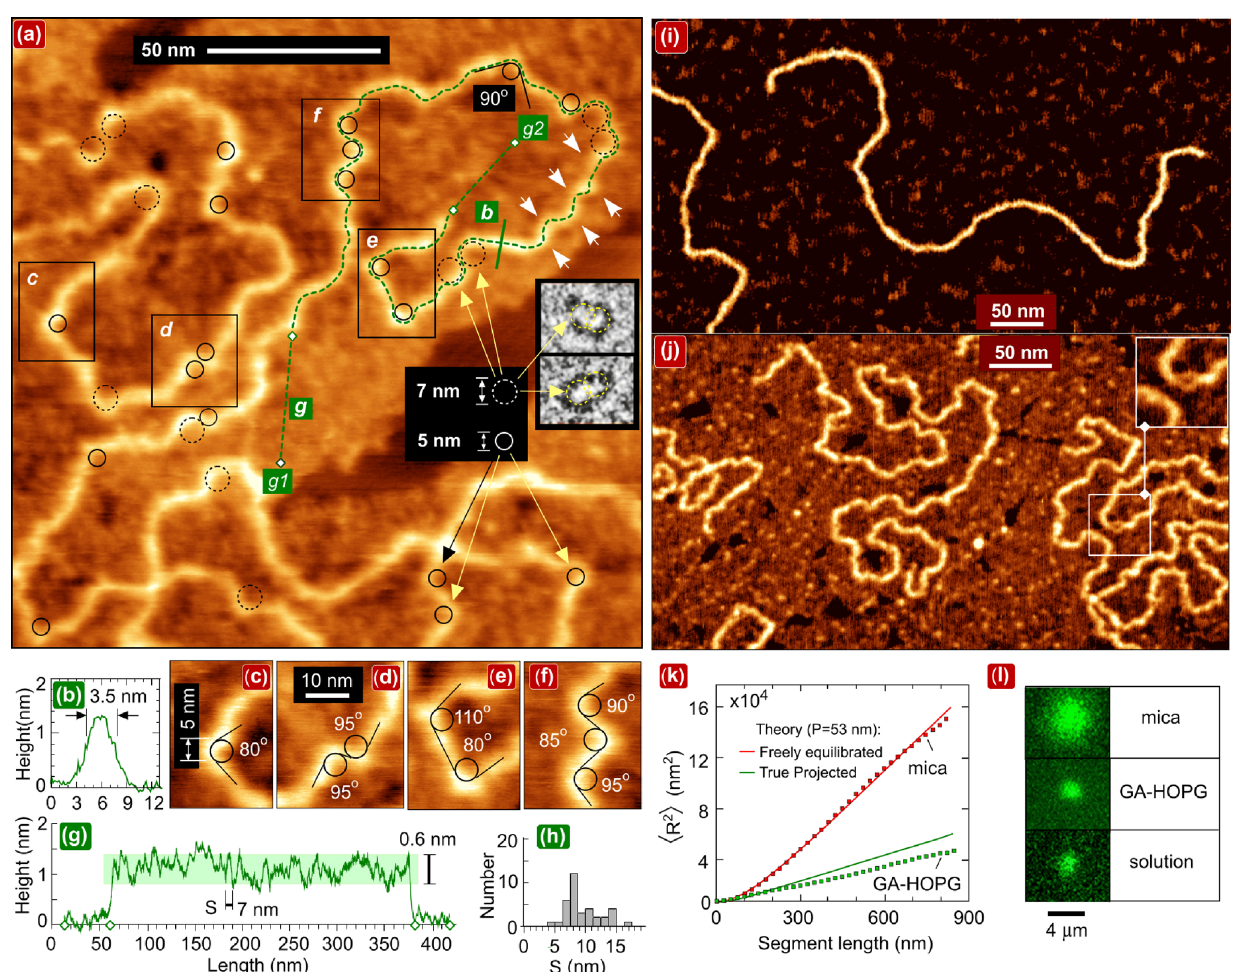
Fig. 1 AFM imaging of kinetically trapped kinked DNA. a High‑resolution AFM topography image in air of pUC19 DNA on the uniform GA/HOPG film. Bending undulations are shown by white arrows and kink sites are marked by black circles. The scan size is 180 nm, and the sampling resolution is 0.18 nm/pixel. The two insets on the right are EM images of kinked doubly gapped mini‑circles, reproduced with the same scale from ref11 licensed under CC BY‑NC 3.0. b The profile drawn across DNA along the green line b in (a). c–f Zooms of rectangular areas c to f in (a). g The longitudinal DNA profile drawn along the dashed line between points g1 and g2 in (a). h The histogram of the distribution of segment lengths between adjacent height minima in the longitudinal profiles. i, j Visual comparison of the low and large scale behavior of (i) the smooth freely equilibrated pUC19 DNA confor‑ mations on mica and (j) the undulated “projected” conformations on GA/HOPG. The inset in the top‑right corner of Fig. 1j shows the melting bubble. The size of scans is 550 nm (i) and 460 nm (j). k Experimental dependences of mean‑square end‑to‑end distance 〈 R 2 (L) 〉 as a function of the segment length for DNA adsorbed on GA/HOPG (lower branch) and on mica (upper branch). The red and green solid lines are theoretical dependences for the DNA with the persistence length P = 53 nm plotted for the 2D freely equilibrated and projected conformations, respectively, in accordance with relationships in ref 17. l The direct optical visualization of single fluorescently labeled lambda‑DNA coils in a bulk solution and adsorbed on mica and